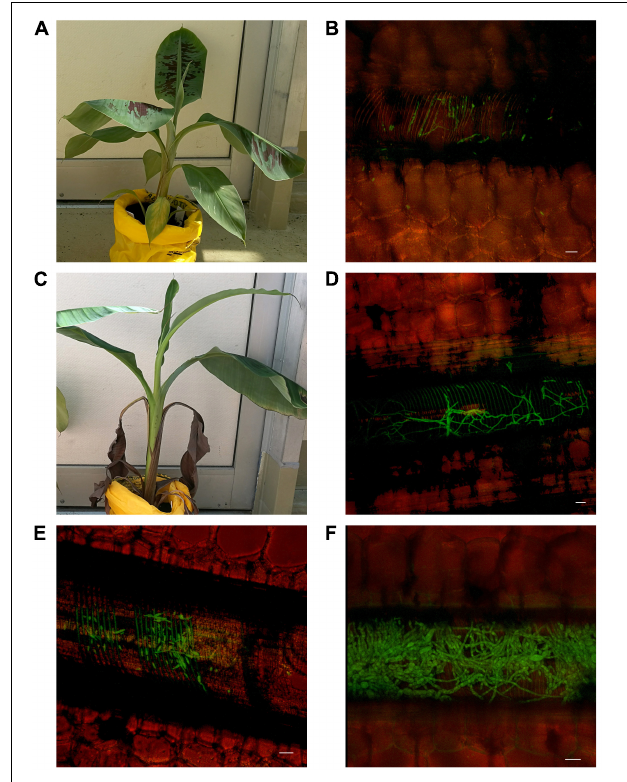
FIGURE 7 | Presence of fluorescing Fusarium oxysporum f.sp. cubense in the mid rib of leaves above the throat of Lady Finger and Cavendish banana plants. (A,B) Cavendish plant 30 dpi inoculated with Foc GFP showing limited symptoms of Fusarium wilt with hyphae and microconidia confined to non-discolored xylem vessels of midrib above the throat. (C,D) Lady Finger plant 50 dpi inoculated with Foc GFP showing hyphae confined to discolored xylem vessel in the midrib of leaf above the throat. (E) Cavendish leaf 50 dpi with germinated microconidia confined to xylem vessel. (F) Lady Finger leaf 60 dpi, with extensive mycelium appearing to block the xylem vessel. Scale bars represent 20 µ